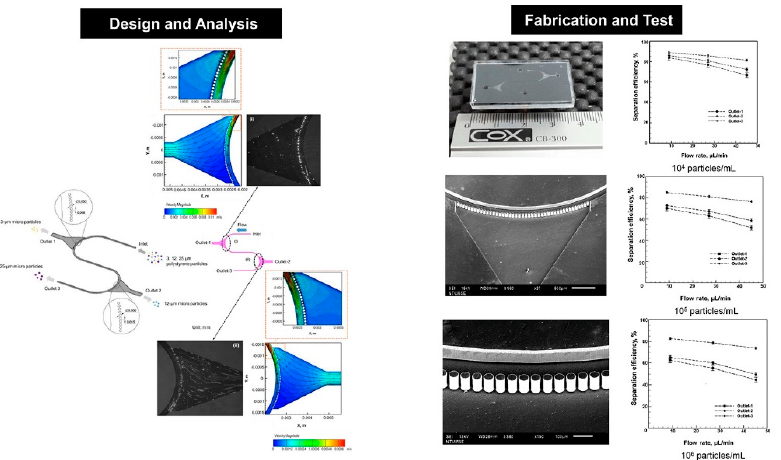
Figure 4. Crossflow microfilter with multistage dual arc-unit structures. The figure has been reproduced with permission from Elsevier [141].